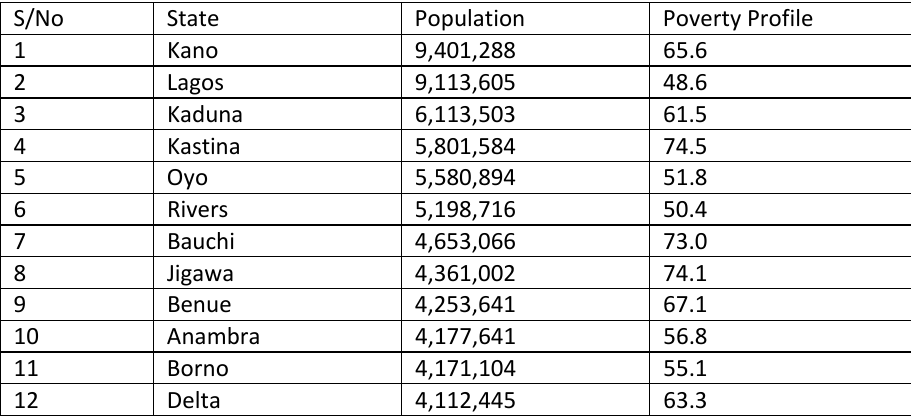
Table 2. Distribution of Poverty in